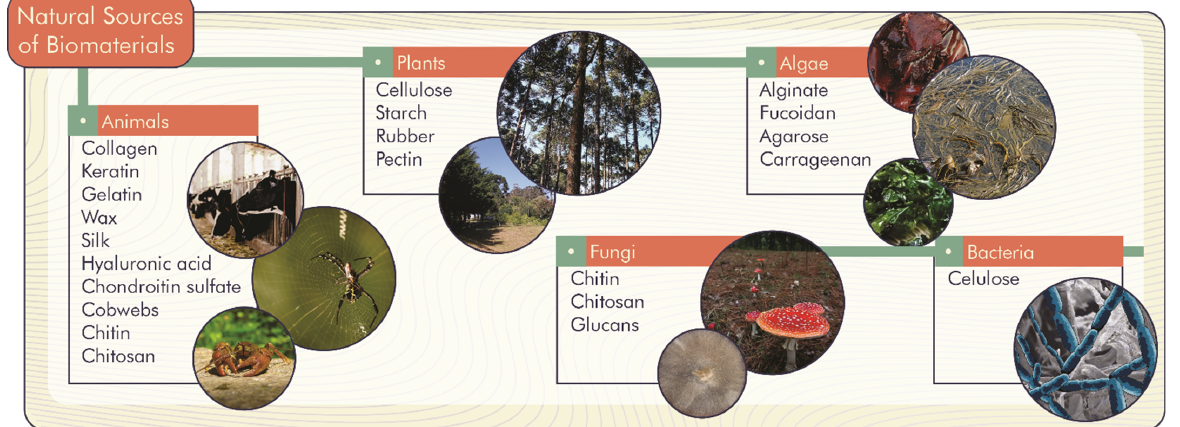
Figure 1. Primary natural sources of biomaterials.